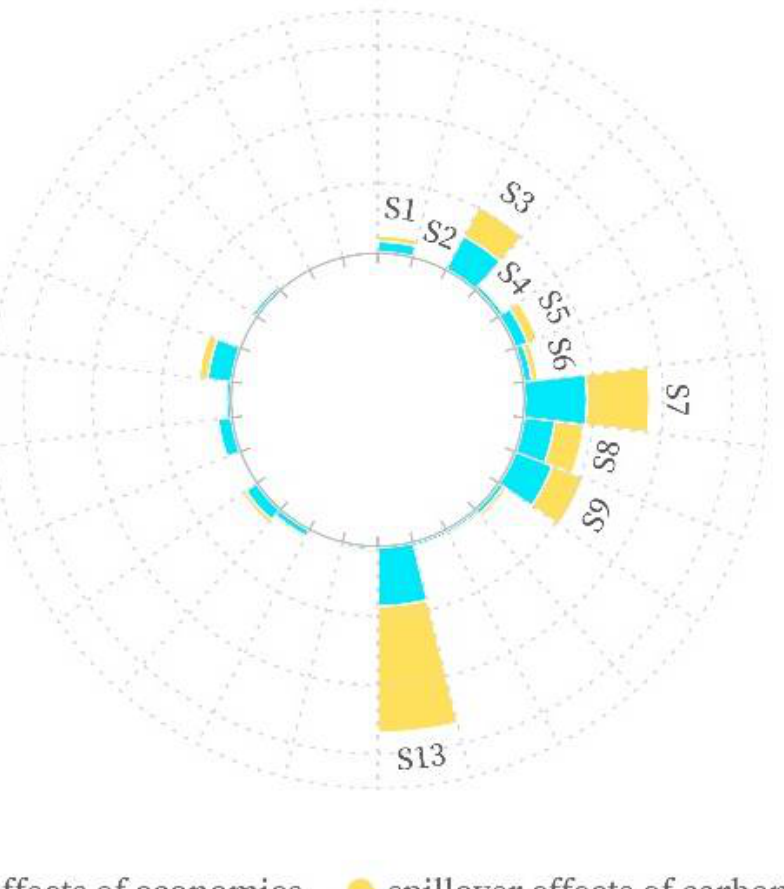
Figure 7. Comparison of CSE and ESE.